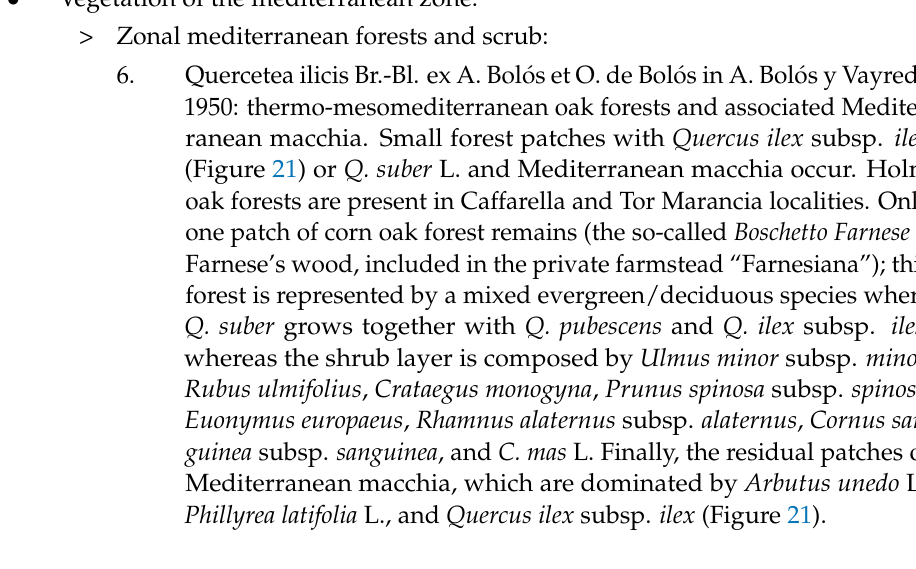
Figure 20. Lolium perenne dominated community, Cynosurion cristati (Divino Amore locality).